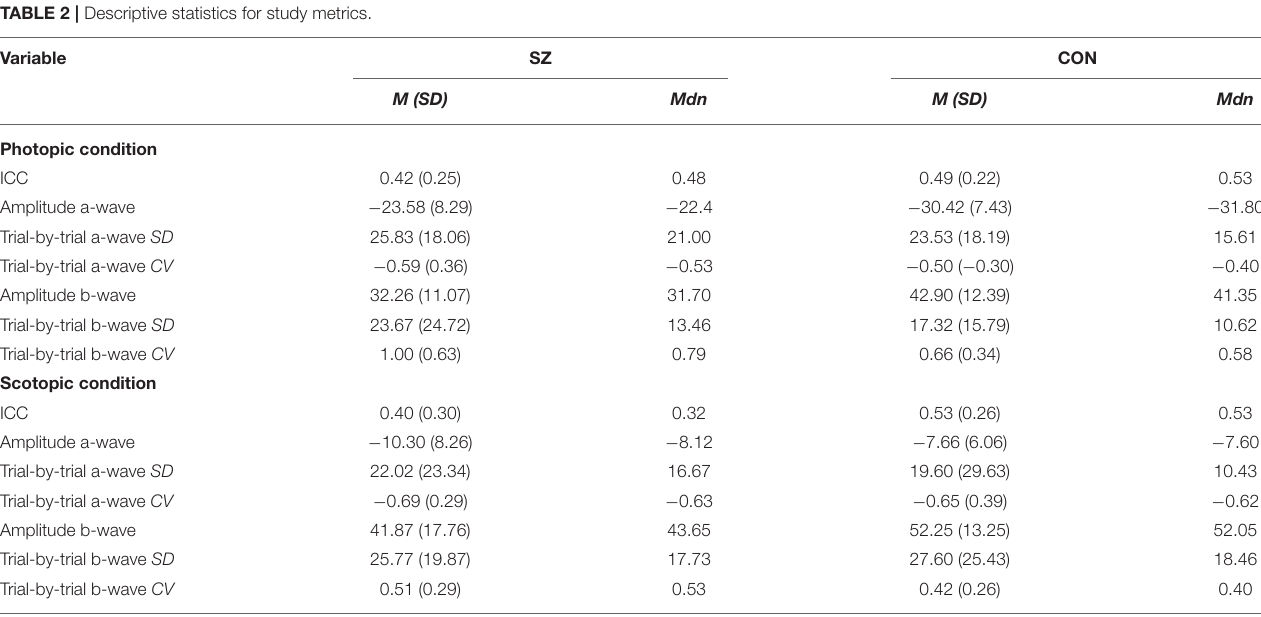
TABLE 2 | Descriptive statistics for study